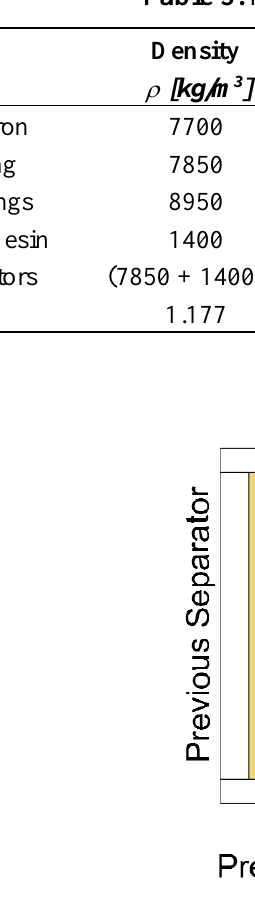
Figure 10. Normalized heat generation in an axial-flux motor. Table 3. Parameters of the thermal model.